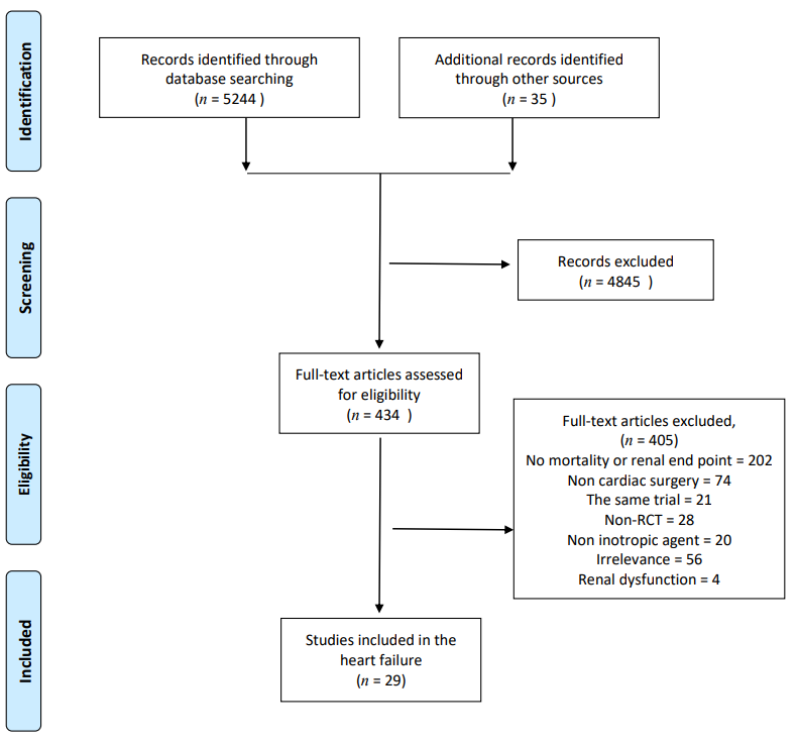
Figure 1. Preferred Reporting Items for Systematic Reviews and Meta-Analyses (PRISMA) flow diagram of randomized controlled trials included and excluded. Non-RCT: none randomized controlled trials.